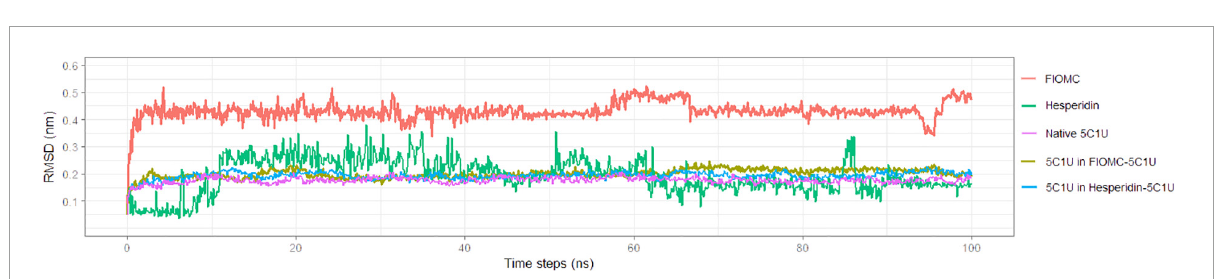
FIGURE8 The stability of protein 5C1U and ligands through molecular dynamics simulation of two systems 5C1U-FIOMC and 5C1U-Hesperidin. The MD simulation was done with Gromacs version 2022.2 through 100 ns (Berendsen et al., 1995; van der Spoel et al., 2005; Abraham et al.,